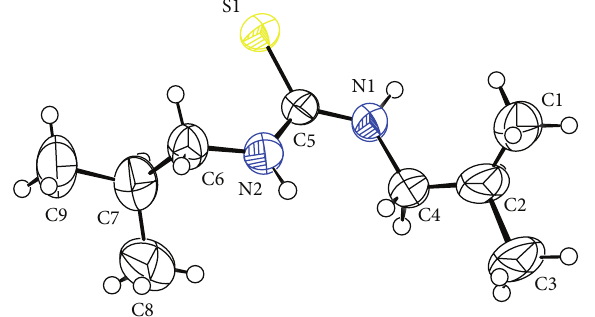
Figure 1: Crystal structure (ORTEP plot) of 1,3-diisobutyl thiourea molecule with labeling